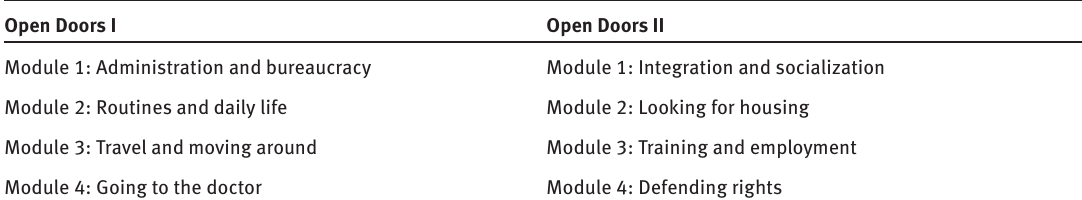
Table 2: Module structure of Open Doors I and II Open Doors